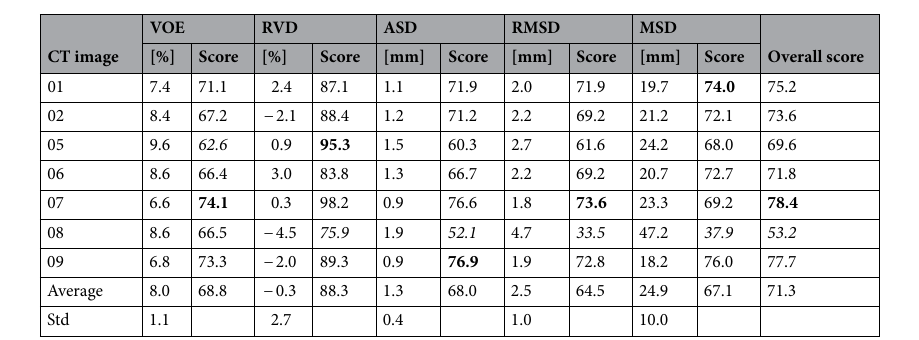
Table 6. The evaluation metrics and overall score obtained from 7 asymptomatic (unlabeled) cases. The bold means the best values in each column.